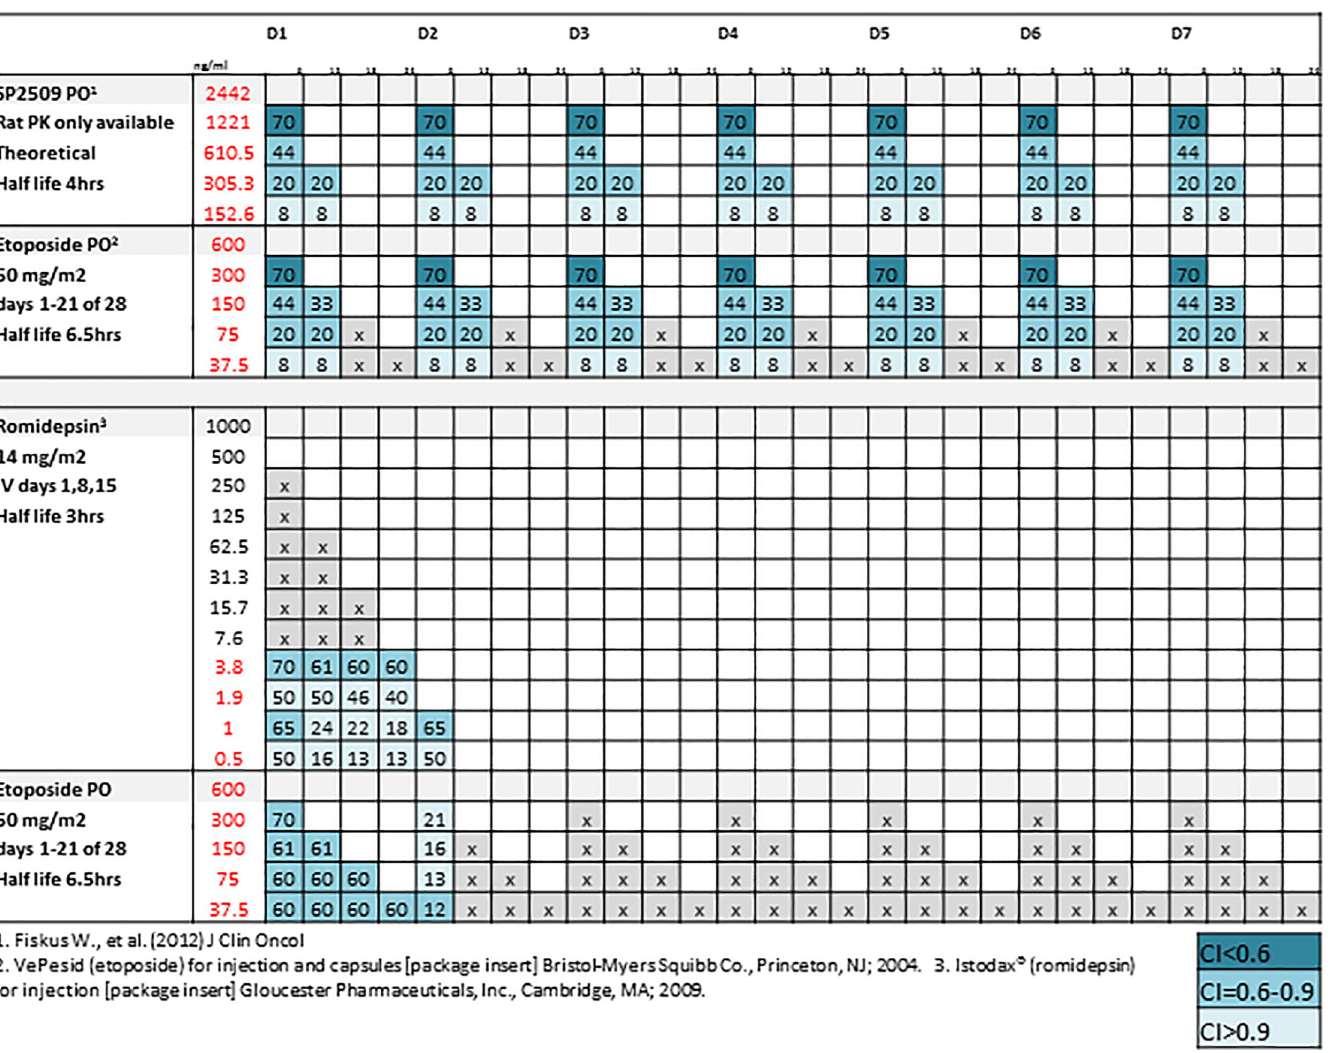
Fig 5. Clinical schedules and corresponding PK predicted activities for combinations of interest. Dosing schedules for a 7-day treatment of oral etoposide paired with SP2509 and romidepsin. Plasma concentrations and estimated half-life for single-drug administration are derived from sources listed. Values in red indicate plasma concentrations comparable to experimental concentrations used. Values in boxes represent expected FA at given concentrations. Color represents amount of synergy expected. Gray boxes represent untested concentration combinations.